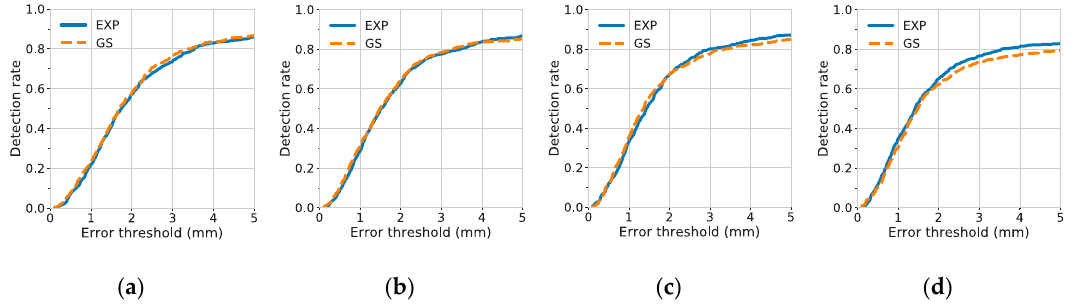
Figure 7. Detection rate of the posterior corner of the sacrum against different degrees of error thresholds. The results of various σ values: ( a ) σ = 6.28; ( b ) σ = 3.14; ( c ) σ = 1.57; and ( d ) σ = 0.79. The detection rates were results from 10-fold cross-validation (mean with 1 standard error band). For each figure, EXP and GS stand for exponential and Gaussian heatmaps, respectively.